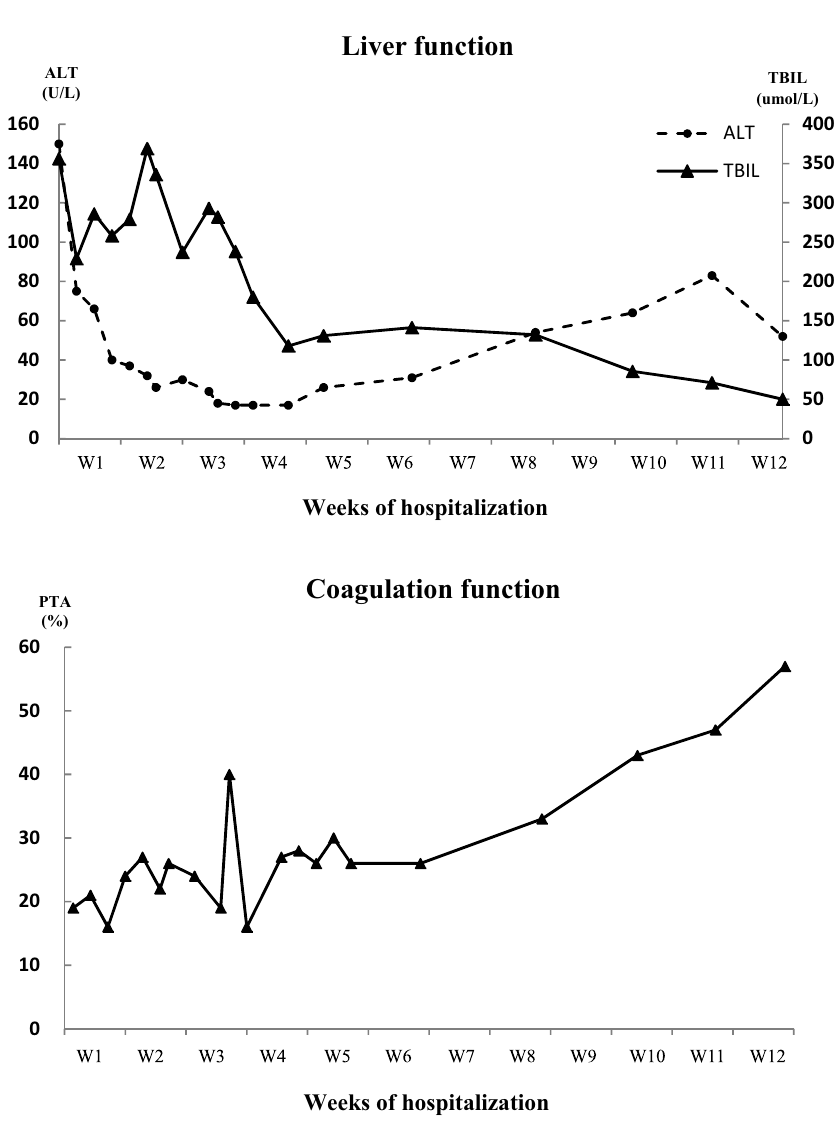
Figure A1: The level of ALT, TBIl and PTA of case 1 during